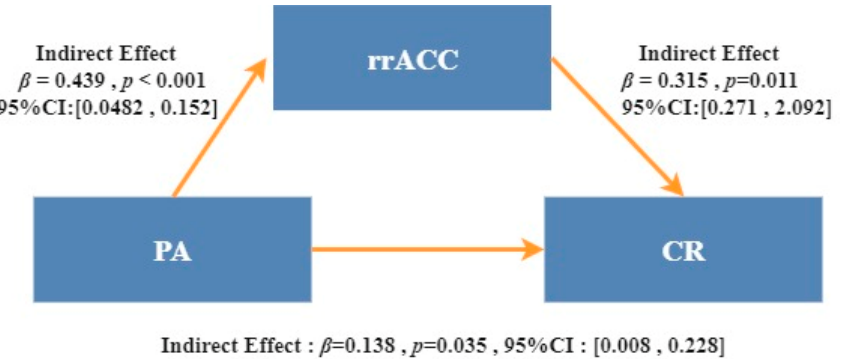
Figure 4. Mediating effects of rostral anterior cingulate cortical thickness (right region) on the relationship between physical activity and cognitive reappraisal. Abbreviations: PA, physical activity; rACC, rostral anterior cingulate cortex; CR, cognitive reappraisal; ES, expressive suppression. The values are standardized coefficients.